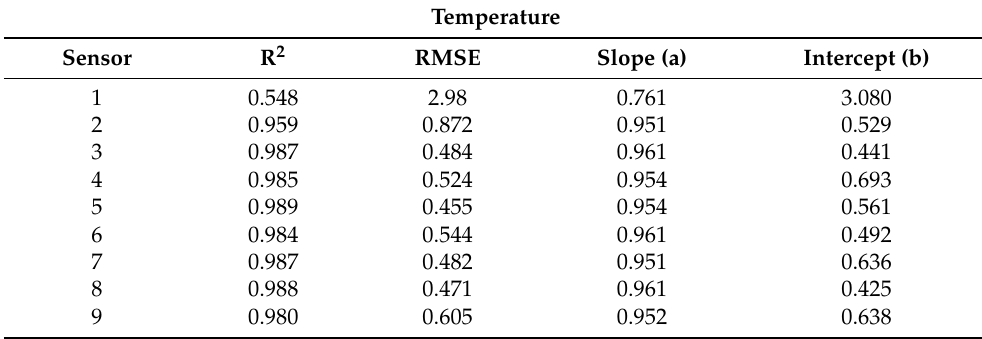
Figure 3. Inter-comparison of temperature between GMX500 sensors. Each panel ( a – i ) corresponds to a sensor under evaluation. The coefficient of determination (R 2 ), the root mean square error (RMSE) and the lineal regression (in blue line) are shown in each panel. Table 1. Statistical results of the inter-comparison of the temperature of the GMX500